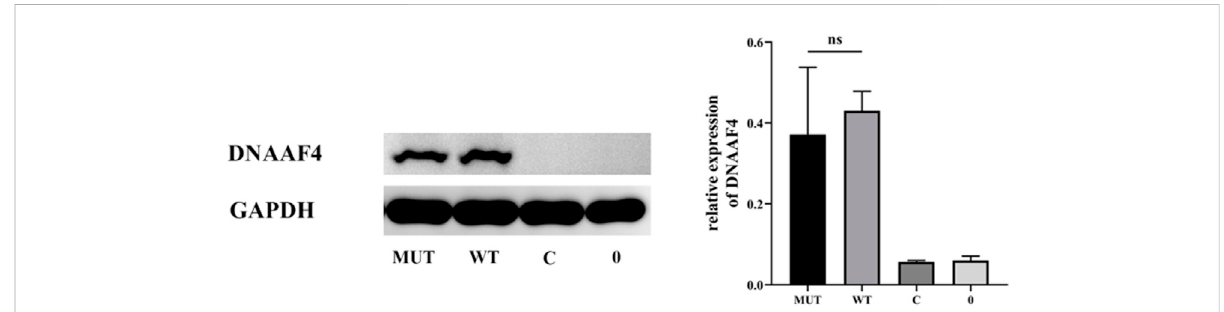
FIGURE 3 Effect of the Mutation on the expression of the DNAAF4 Protein. Forty-8 hours after transfection of plasmid in HEK293T, Western blot showed the expression of DNAAF4 protein. GAPDH is shown as a reference. MUT, mutated DNAAF4-HA plasmid; WT, normal DNAAF4-HA plasmid; C, blank plasmid; and 0, no plasmid. NS means not signi fi cant.